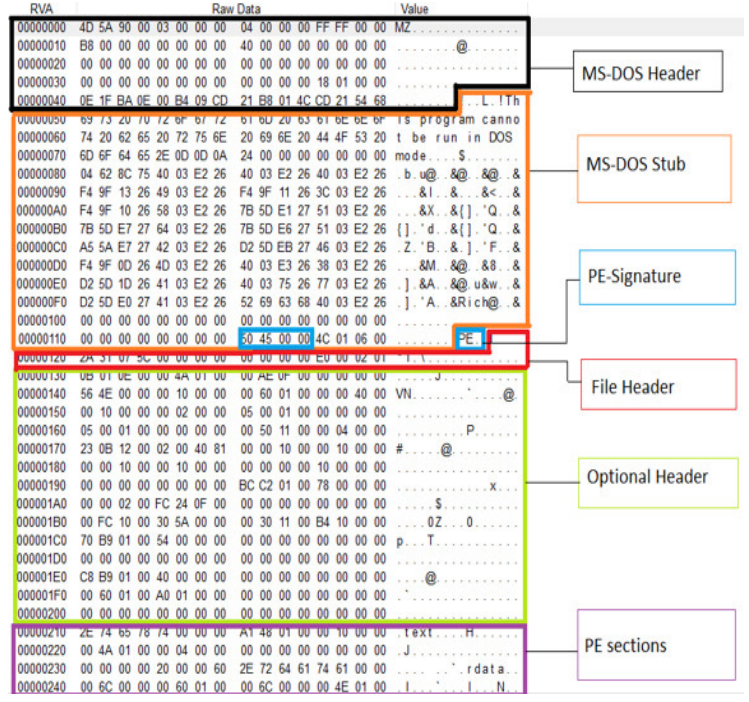
Figure 1. A sample hex dump showing all the headers of the PE file.